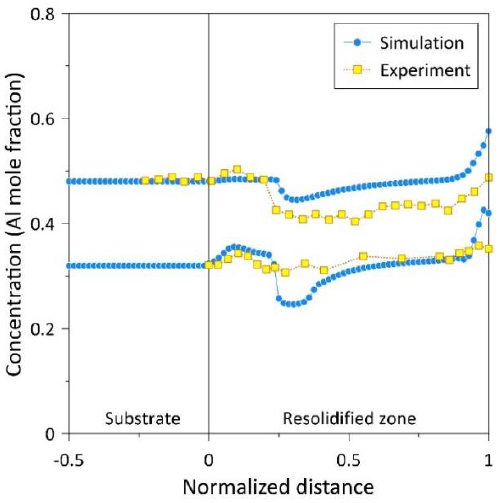
Figure 6. Comparison of the calculated (this work) and experimentally measured (literature, Ref. [26]) Al concentration along the centre line of the melt pool.